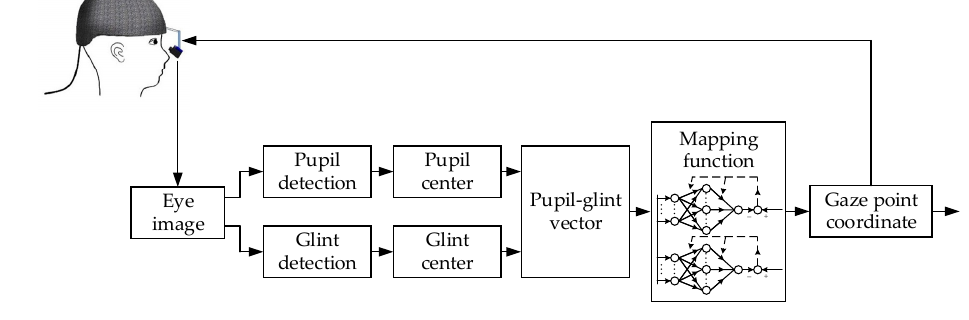
Figure 1. Flow ‐ process of gaze direction estimation. Figure 1. Flow-process of gaze direction